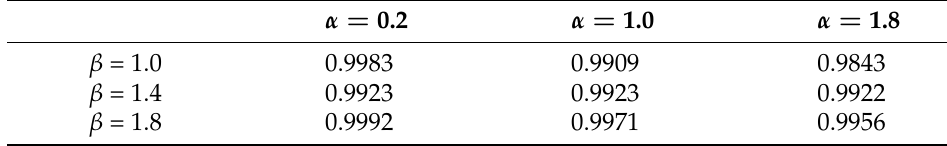
Figure 5. Simulation result at t = 3 in Dagum random fields with columns (from left to right) at α = 0.4,0.6,0.8 and horizontal rows (from top to bottom) β = 0.2,0.4,0.6,0.8. Table 1. Cross-correlation coefficients, Cauchy random field.